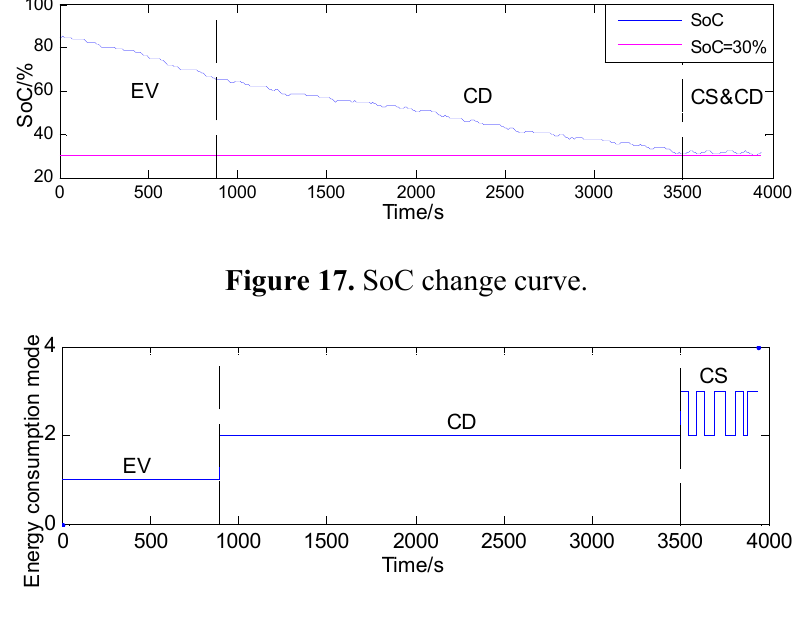
Figure 18. Energy consumption modes